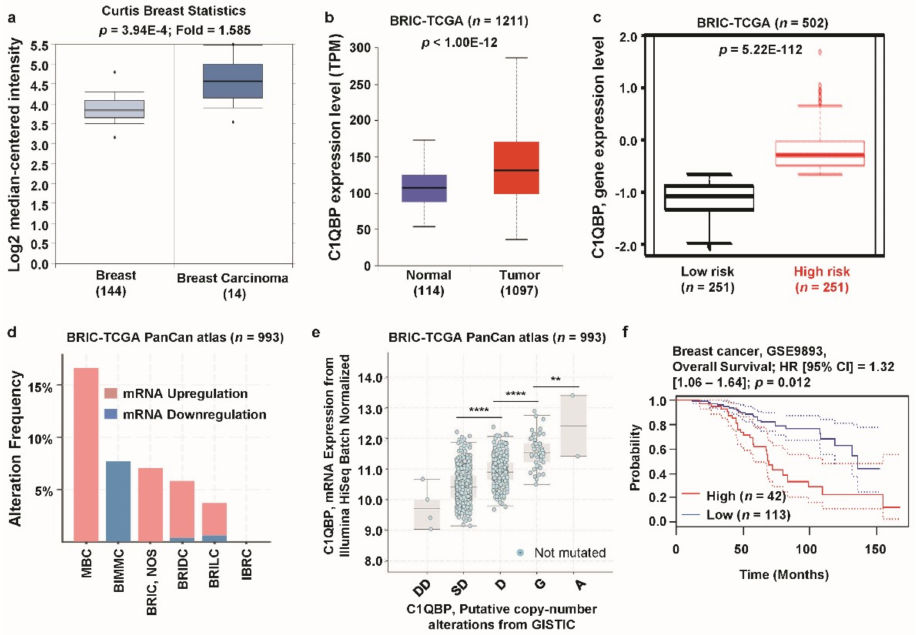
Figure 2. C1QBP expression pattern and patient survival analysis in breast cancer compared to C1QBP expression in normal tissue and cancer tissue. ( a ) The fold-change of C1QBP in breast cancers was identified by our analyses, shown as a box plot. The box plot comparing specific C1QBP